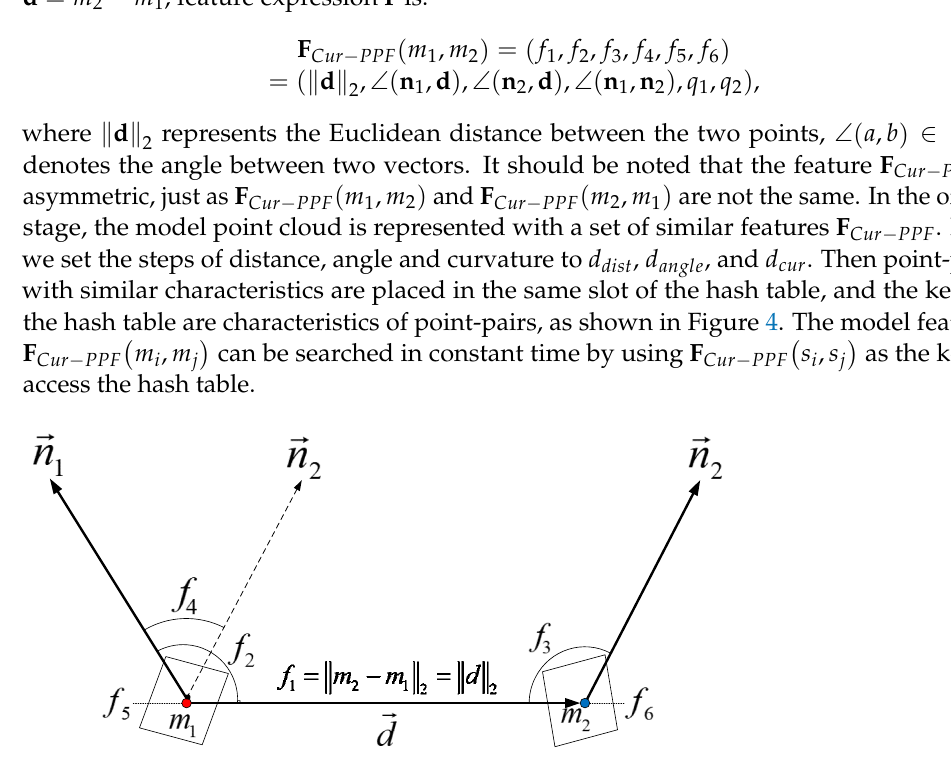
Figure 4. The hash table model. For the three point-pairs on the model, because point-pairs (